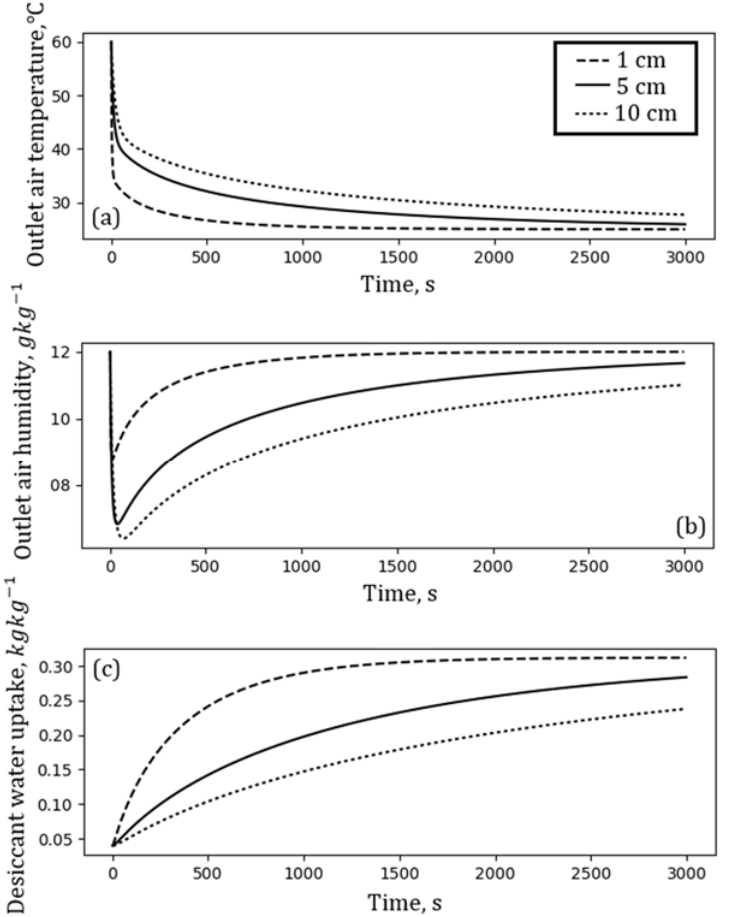
Figure 12. The influence of desiccant filling height on adsorption characteristics: ( a ) Outlet air temperature; ( b ) Outlet air humidity; ( c ) Desiccant water uptake.